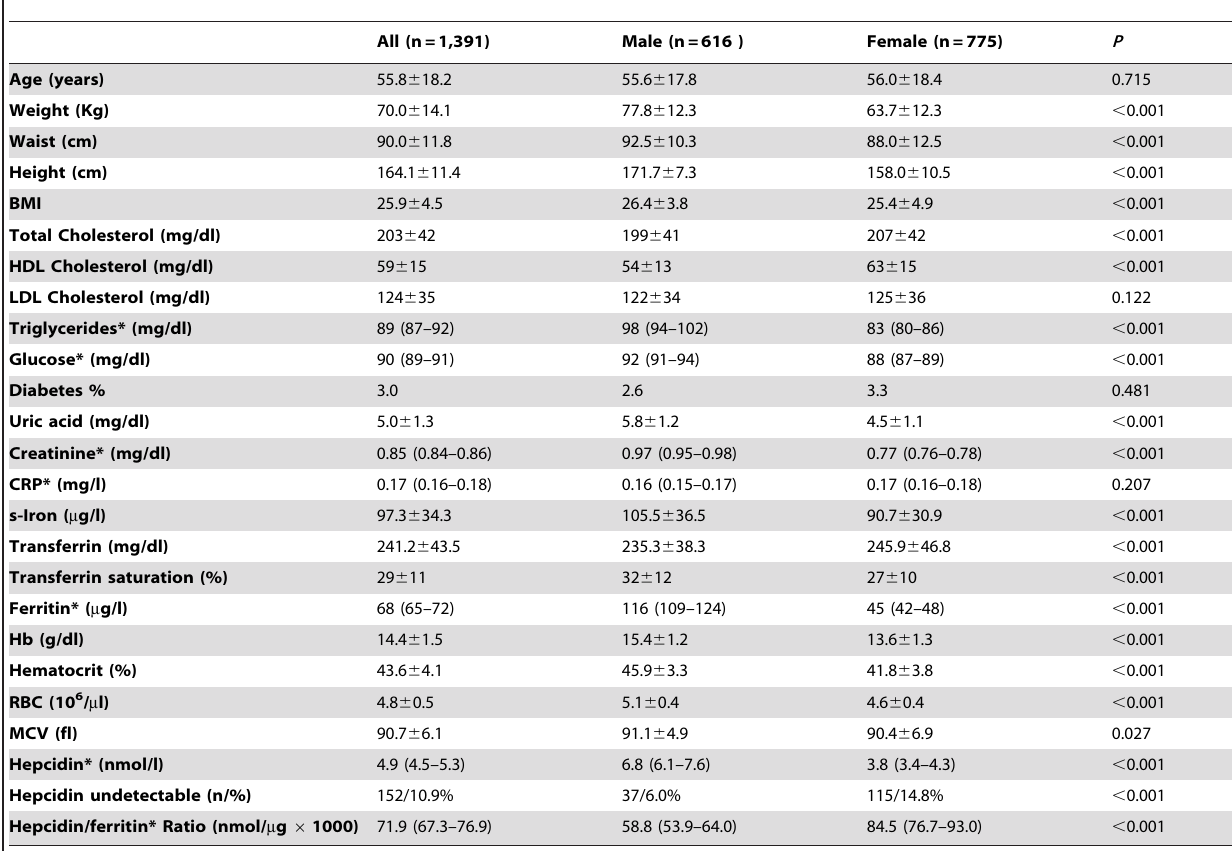
Table 1. Clinical, anthropometrical, and biochemical data of the VB population.